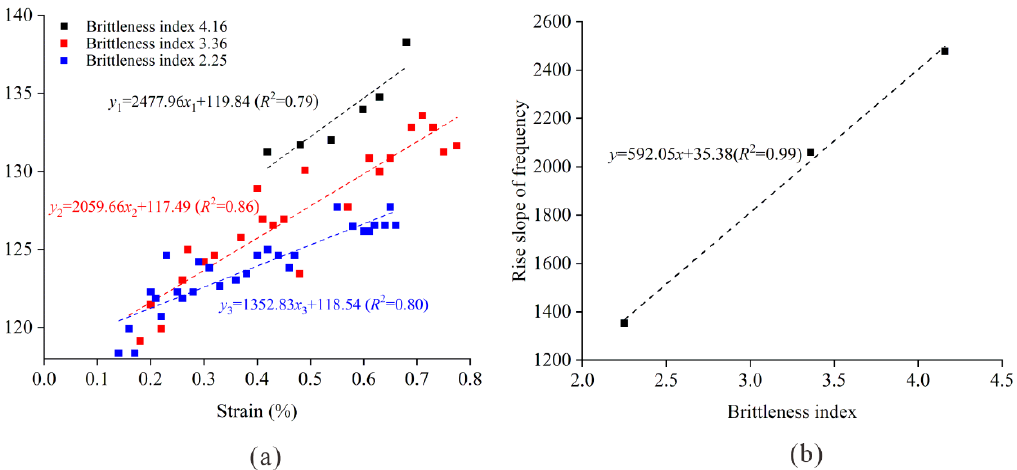
Figure 18. Law of natural frequency during the stable crack growth stage: ( a ) linear fitting of frequency and ( b ) linear fitting of the rise slope of the frequency and brittleness index.